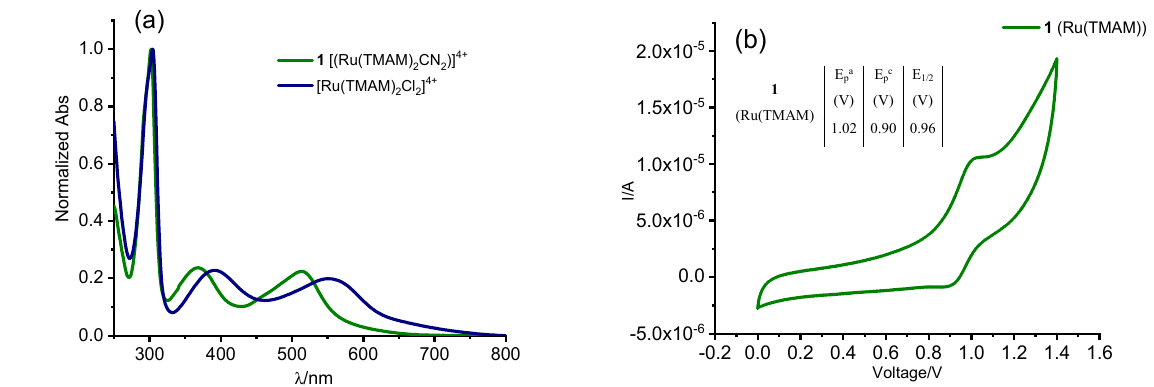
Figure 2. ( a ) Comparison between the normalized absorption spectra of 1 [Ru(TMAM) 2 CN 2 ] 4+ (green line) and of the precursor [Ru(TMAM) 2 Cl 2 ] 4+ (violet line) values in ethanol. ( b ) Cyclic voltammetry of 1 (Ru(TMAM)) in 0.1M LiClO 4 /ACN at 50 mV/s at a glassy carbon electrode. Voltage is referred to SCE.